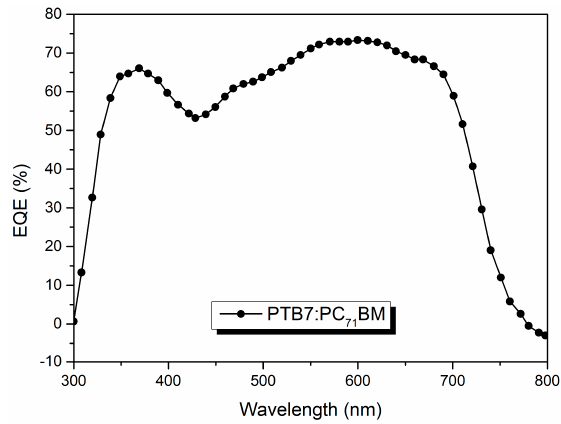
Figure 17. EQE curve obtained for PTB7:PC 71 BM active layer blend.